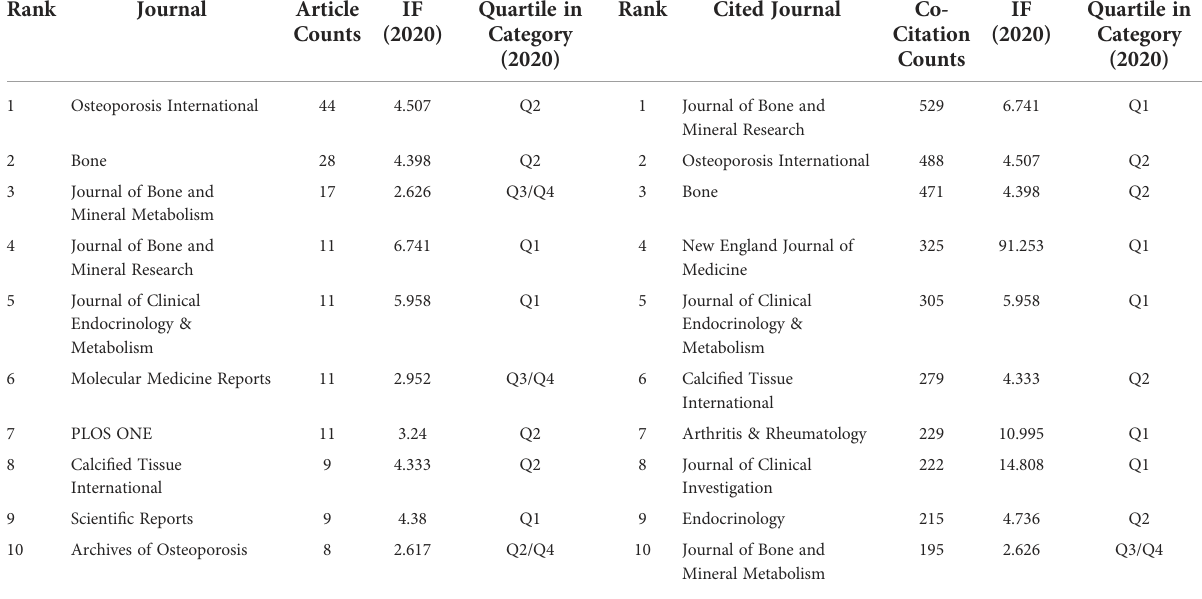
TABLE 5 The top 10 journals distributed by publications and